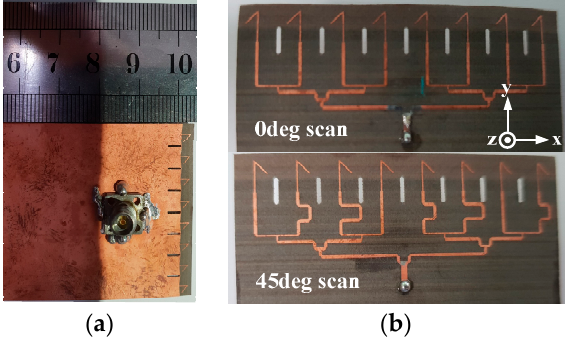
Figure 12. Fabricated 1 × 8 array antenna: ( a ) top view ( b ) bottom view.